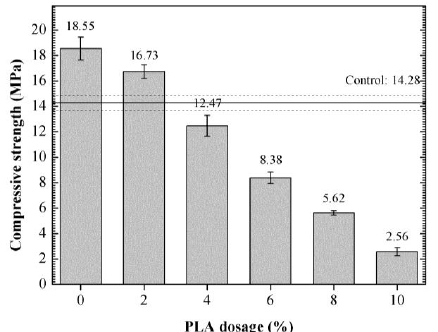
Figure 6. Compressive strength of 85 °C-cured specimens of the control and SDTSMs with different PLA dosages.